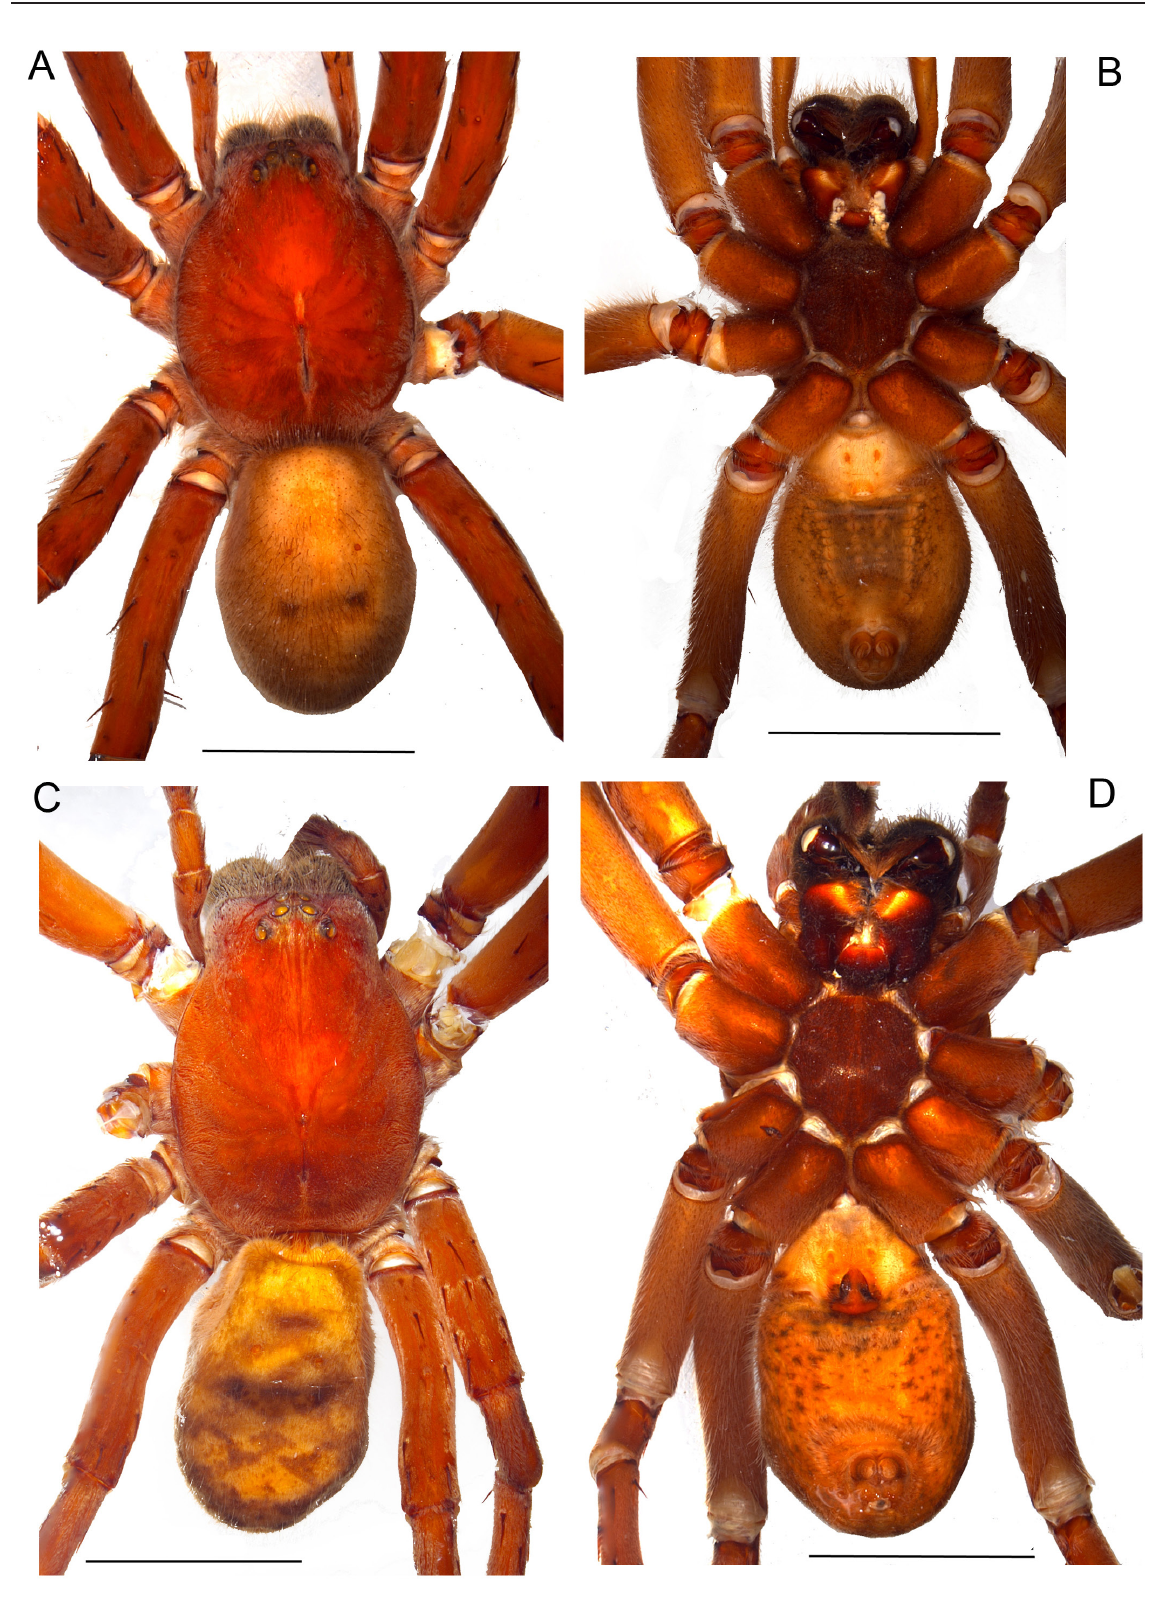
Fig. 6. Afroneutria erythrochelis (Simon, 1876) comb. nov. Habitus. A . ♂ , dorsal view. B . ♂ , ventral view. C . ♀ , dorsal view. D . ♀ , ventral view. Scale bars = 10